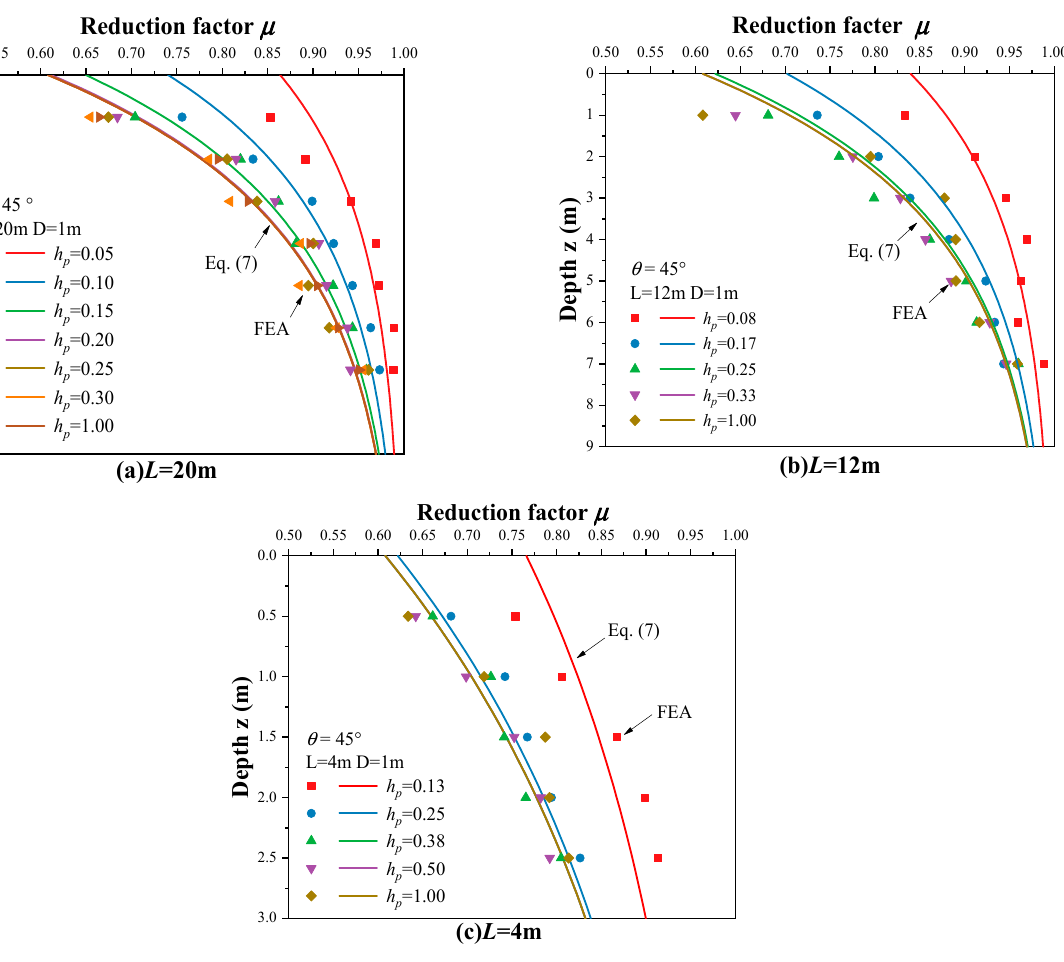
Figure 17. Effect of ℎ (cid:2926) on 𝜇 for pile length of ( a ) 20 m , ( b ) 12 m, and ( c ) 4 m .